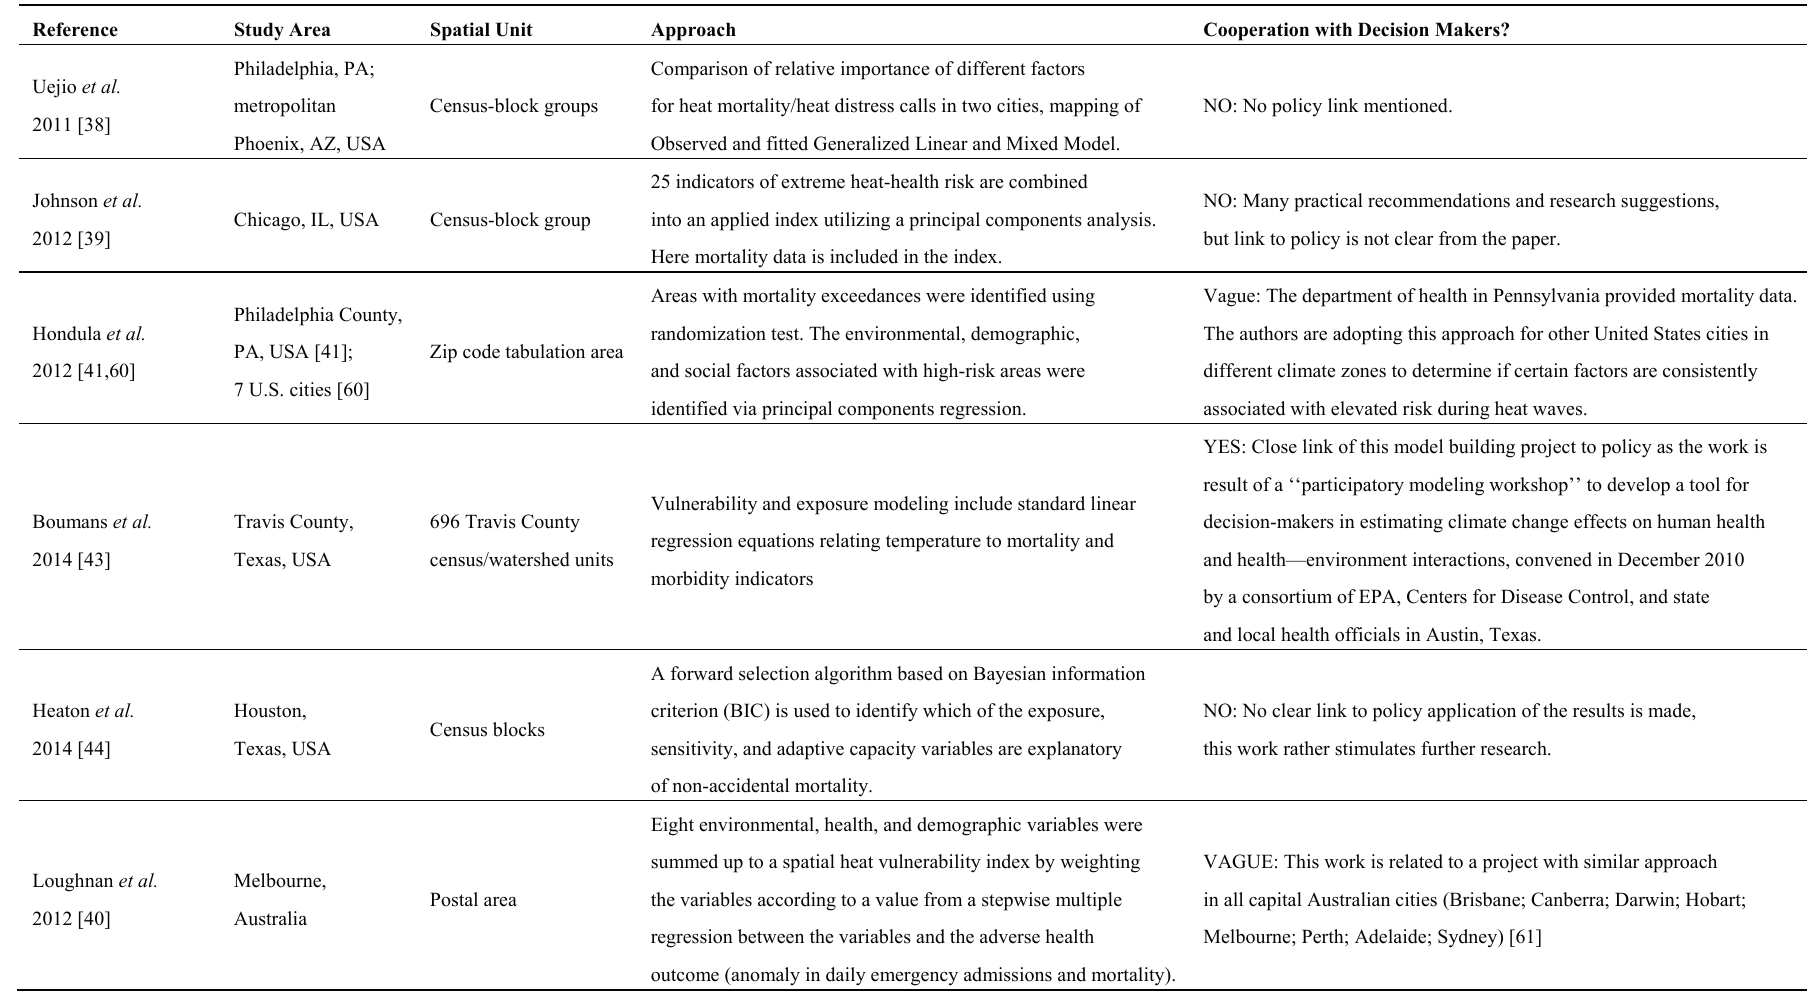
Table 3. Papers on mapping health outcomes and exploring vulnerability